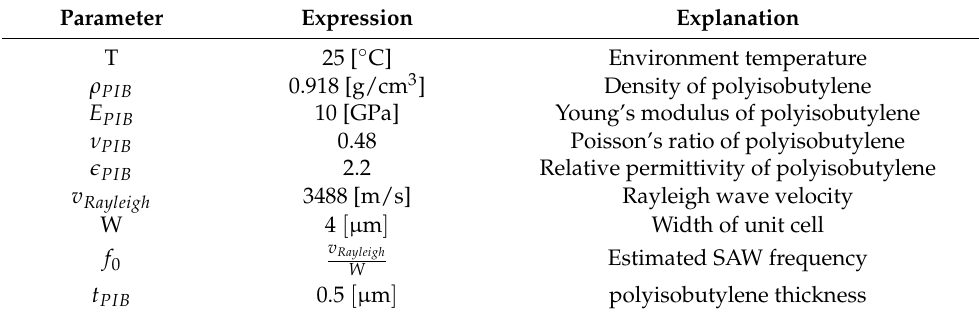
Table 3. Polyisobutylene